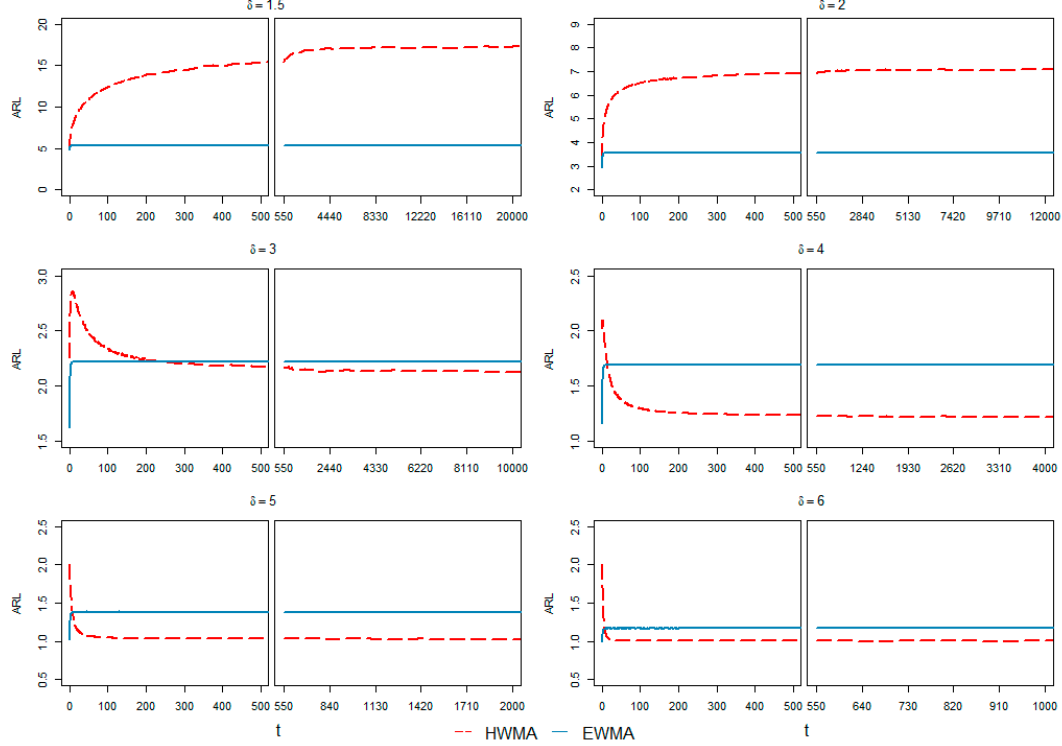
Figure 9. CED curves for the HWMA and EWMA charts under moderate to large shifts at 𝜆 = 0.25 with respect to time points (𝑡) .